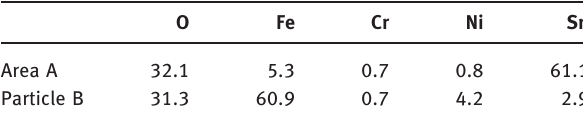
Table 2: Chemical composition at the selected regions (shown in Figure 2(d), wt.%).